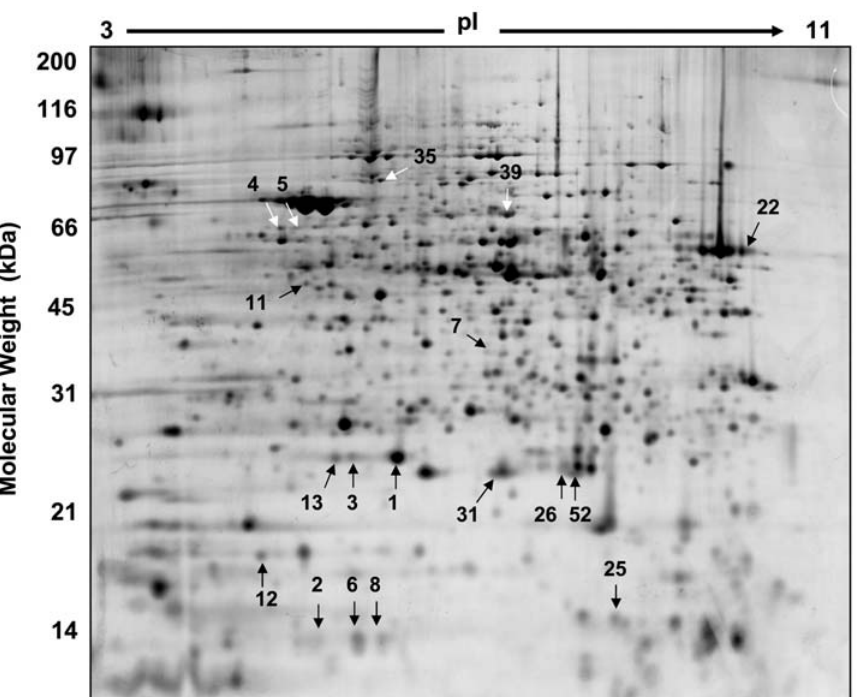
Figure 2. Regulated proteins of the S.solfataricus proteome after exposure to 30 m M H 2 O 2 . Approximately 818 spots (common to all gels) were used in the CyDye 2D DIGE analysis. 18 protein spots changed significantly in abundance 105 minutes post H 2 O 2 . Spots that changed in abundance are indicated with arrows. Protein identifications were made using in-gel proteolysis followed by LC-MS/MS and are listed in Table 2 .